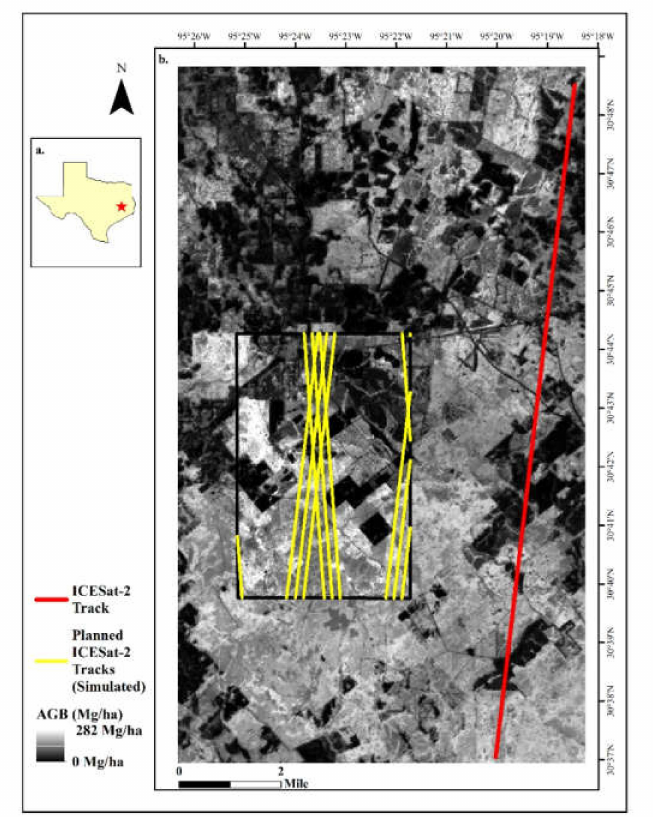
Figure 2. ( a ) Map of Texas with the study site highlighted; ( b ) a 13-mile Ice, Cloud, and land Elevation Satellite-2 (ICESat-2) transect (GT3R) overlaid on a reference aboveground biomass map (biomass density in Mg / ha) for the study area and showing simulated ICESat-2 tracks (yellow) over the extent of Sam Houston National Forest (SHNF) within the study site. The map uses a gray-scale symbology, where lighter pixels represent higher levels of biomass. Non-forested areas have been